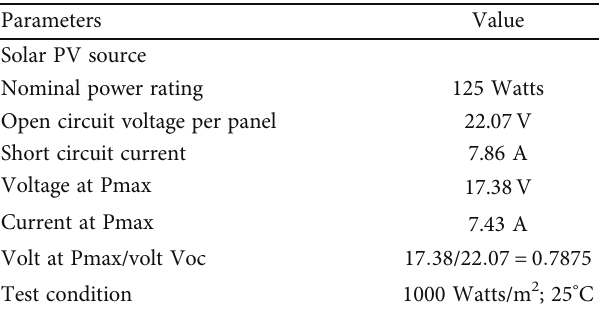
Figure 18: Photograph of the prototype. Table 3: Speci fi cations of the SPV module used for the prototype.